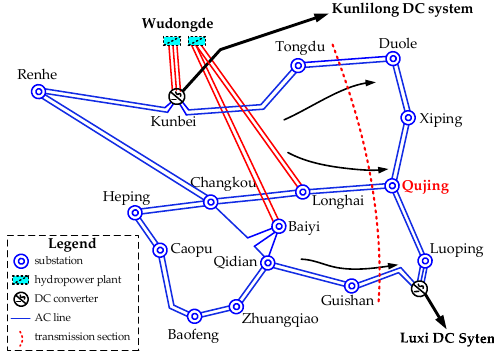
Figure 5. Partial structure of Yunnan 500 kV Power Grid.